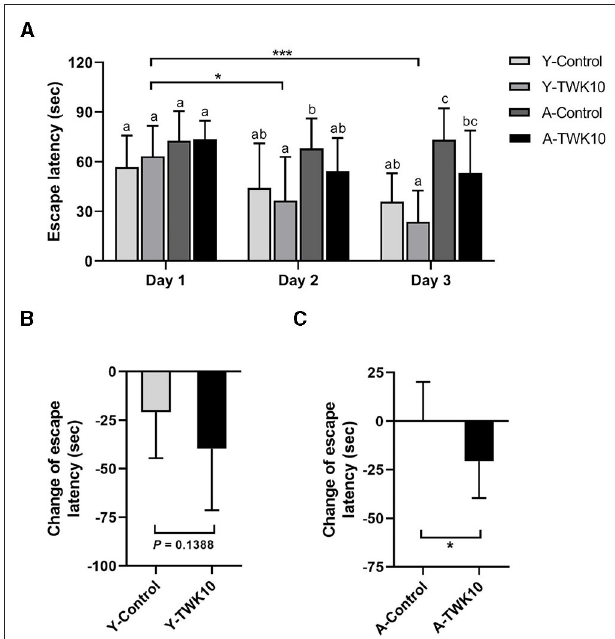
FIGURE 2 | The decline in spatial learning and memory was attenuated by Lactobacillus plantarum TWK10. Spatial learning and memory ability were evaluated using the Morris Water Maze after 8 weeks of TWK10 or PBS administration. (A) Mean escape latency to the platform were recorded during trial days 1, 2, and 3. (B,C) The differences in escape latency between day 1 and day 3 were examined in young and aged mice. Data are represented as mean ± SD. Statistical differences among groups in mean escape latency during the trial days were statistically analyzed by two-way ANOVA with the post-hoc Tukey-Kramer test. Different letters (a, b, c) indicate significant differences among the groups, P < 0.05. Two group comparison was analyzed using the unpaired Student t -test. *** P < 0.001. The differences in delta time of escape latency between the Control and TWK10-administered groups were analyzed using the Mann-Whitney U -test. * P <